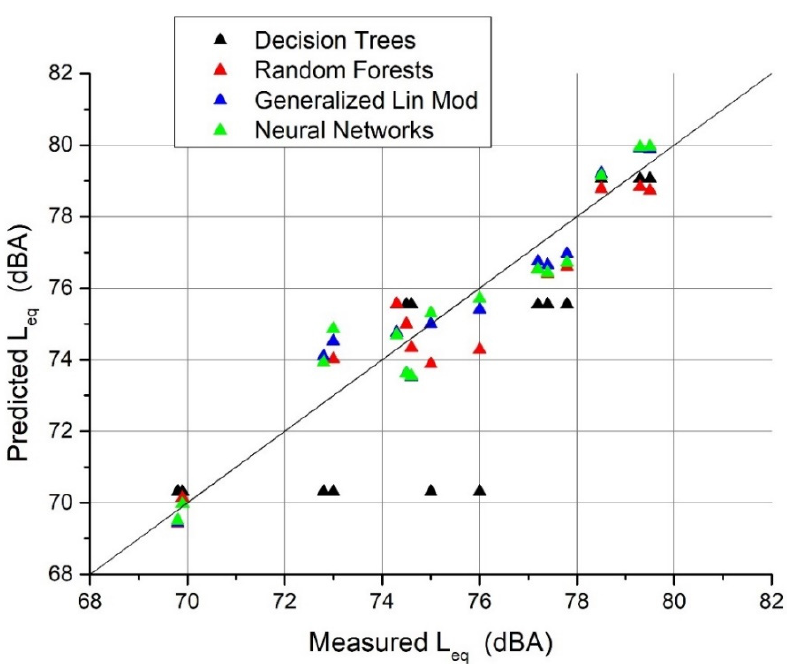
Figure 4. Scatter plot of the models’ predictions versus measured equivalent levels in the training dataset. The black solid line is the bisector and is used as a guide for the eye, to easily identify overestimation and underestimation of the models.